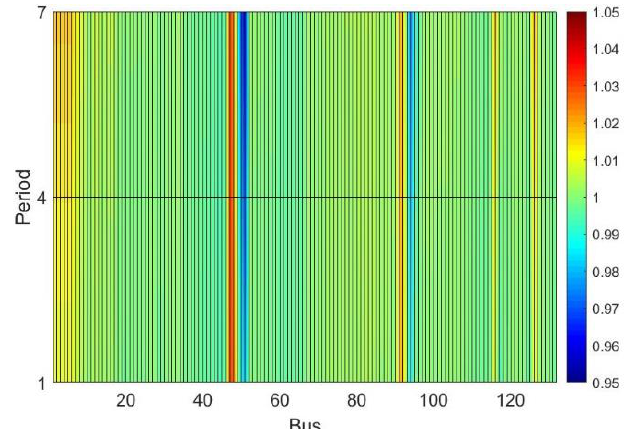
Figure 8. IEEE 123-bus system, voltage magnitudes of phase A, continuous taps, 0% PV.